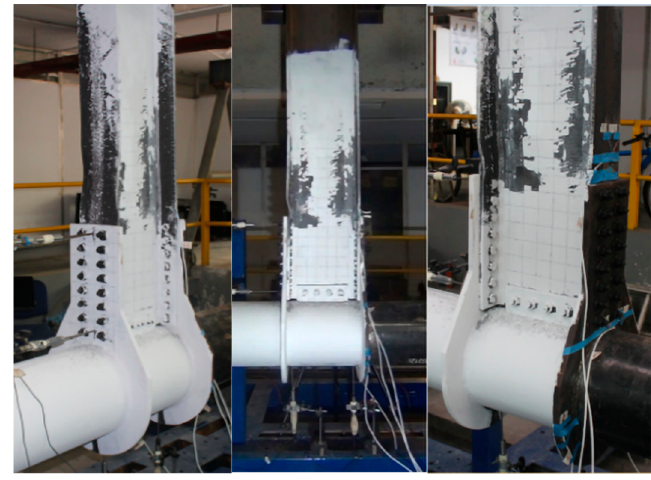
Figure 9. Final state of the specimen during the test seen from different angles.